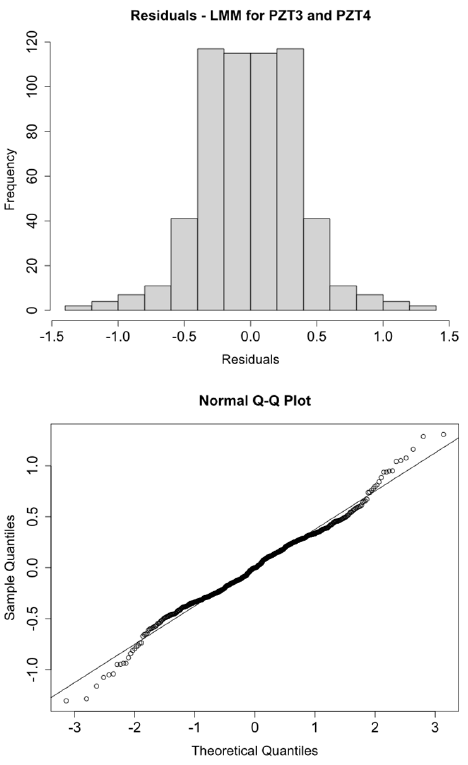
Figure 10. logRMSD histogram and Q-Q plot—Group 2.